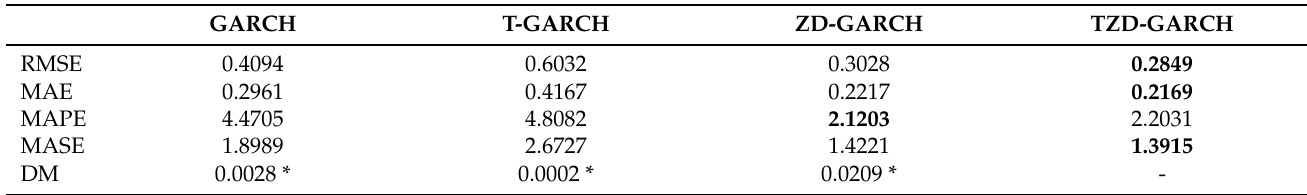
Table 4. Out-of-sample forecasting results: